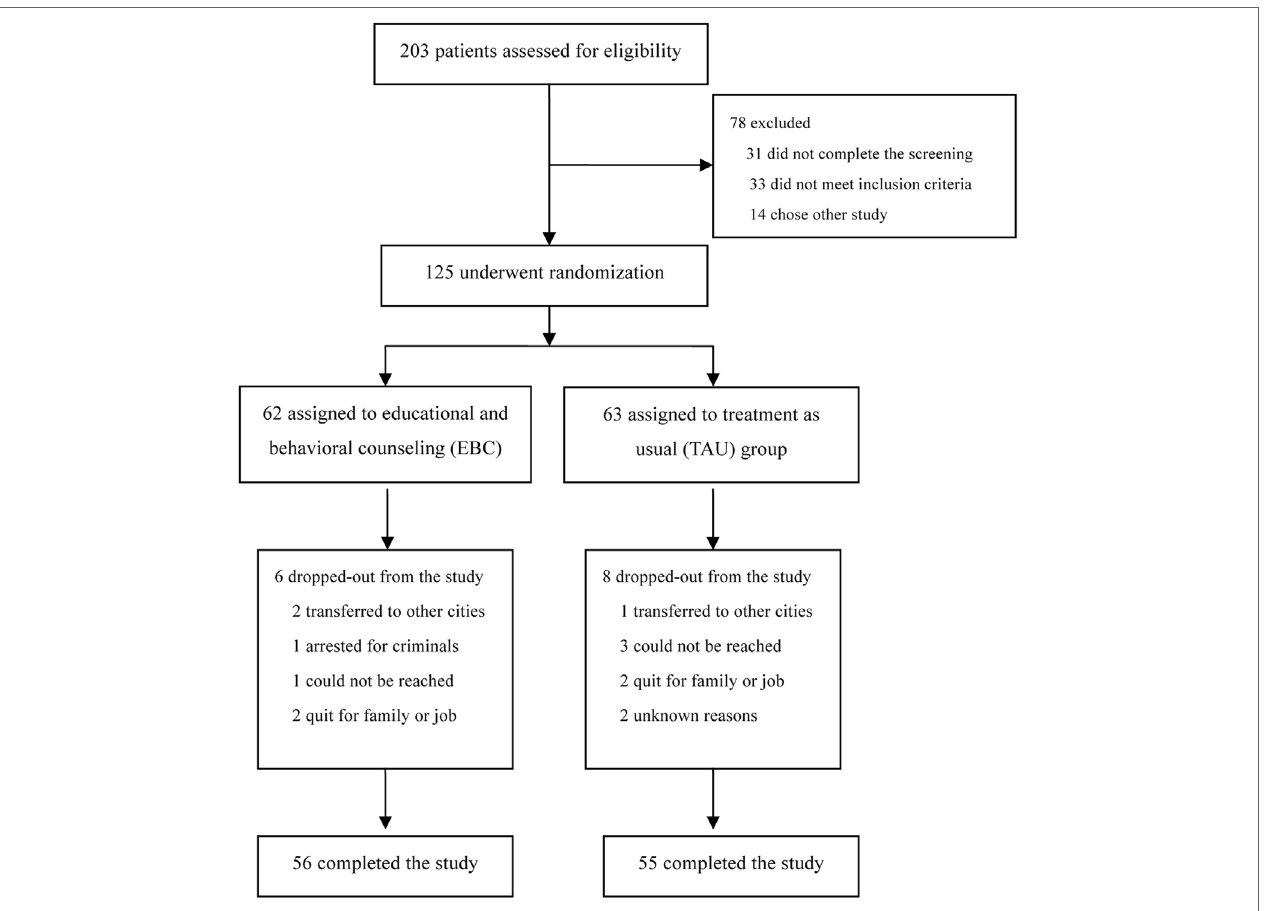
FigUrE 1 | Enrollment and